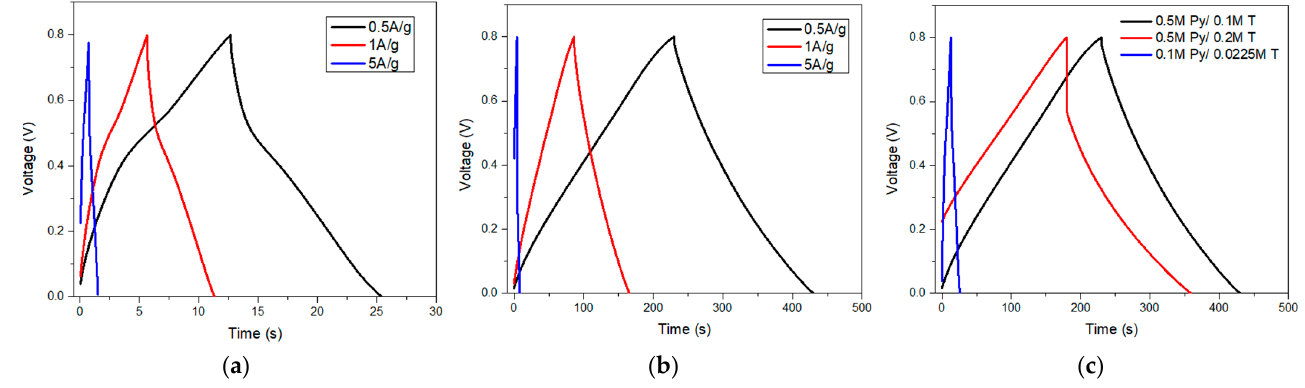
Figure 7. GCD curves for electrodes coated with PPy from ( a ) 0.1 M Py/0.0225M T and ( b ) 0.5M Py/0.1M T at current densities of 0.5, 1, and 5 A/g. ( c ) GCD curves at 0.5 A/g for composite electrodes electro-coated with PPy from 0.5M Py/0.1M T, 0.5M Py/0.2M T, and 0.1M Py/0.0225M T solution, respectively.